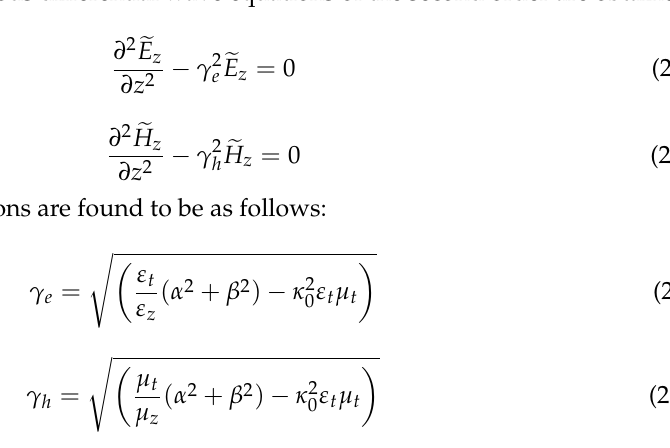
β are the Fourier variables corresponding to the space domain wavenumbers κ x and κ y